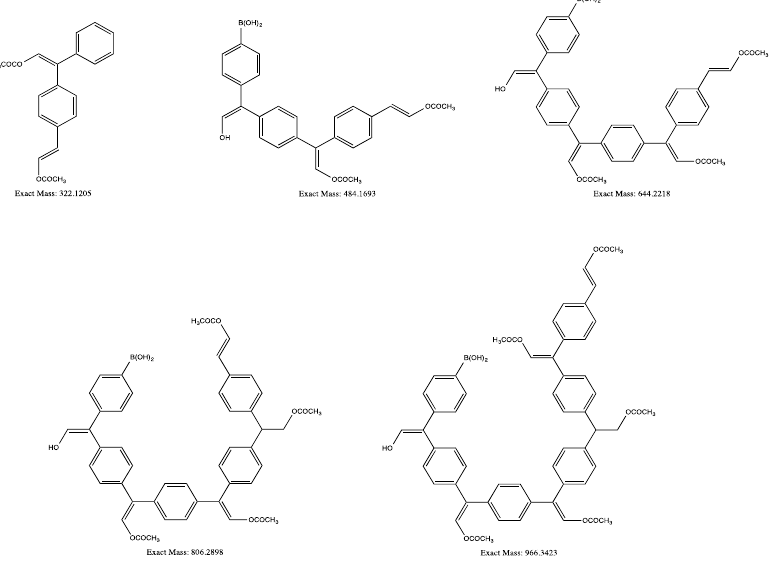
Figure 18. Proposed oligomer structures corresponding to HR-TOF MS data. From top left, n = 2, 3, 4, 5, and 6 where n = number of monomer units in the oligomer.